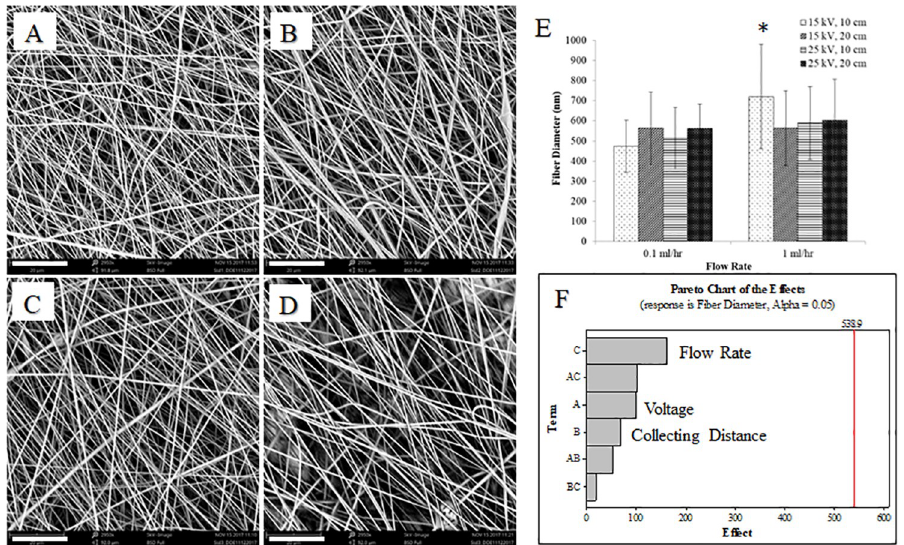
Fig 1. Non-woven PNIPAM nanofiber diameter as a function of collecting distance, flow rate, and voltage. The images in panels A-D are samples at the 0.1 ml/hour flow rate. (A) 10 cm collecting distance, 15 kV applied voltage. (B) 10 cm, 25 kV. (C) 20 cm, 15 kV. (D) 20 cm, 25 kV. Scale bar (lower left of each image) is 20 μ m. Electrospinning parameters held constant: 12% (w/w) PNIPAM:OpePOSS:EMI (100:20:0.3) in a solution of THF:DMF (1:1), 22 ga. needle. (E) Quantitative effects of process parameters on fiber diameter. � p < 0.05 relative to other samples at 1ml/hr flow rate. (F) Pareto Chart of the Effects for analysis of the factorial design shows that flow rate effects fiber diameter the most, although not significantly at the ranges